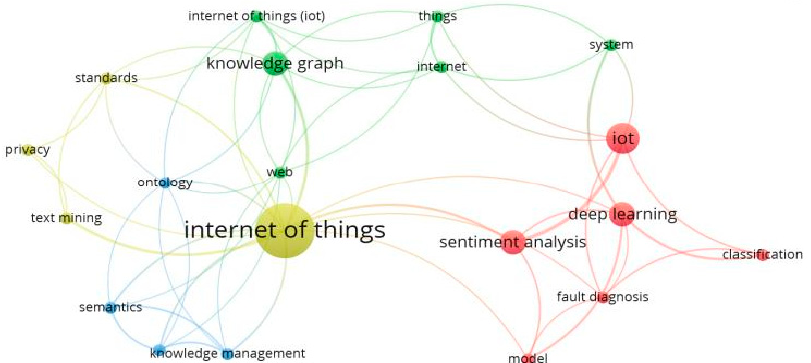
Figure 1. Co-occurrence analytical map of keywords.